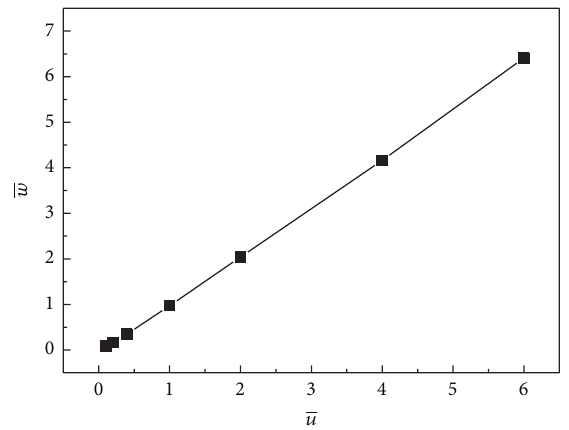
Figure 6: The plot of 𝑤 against 𝑢 at | ⃗𝑢 02 | = 0.005 m/s for the T- shaped microchannel of 𝜑 1 = 0 ∘ and 𝜑 2 = 90 ∘